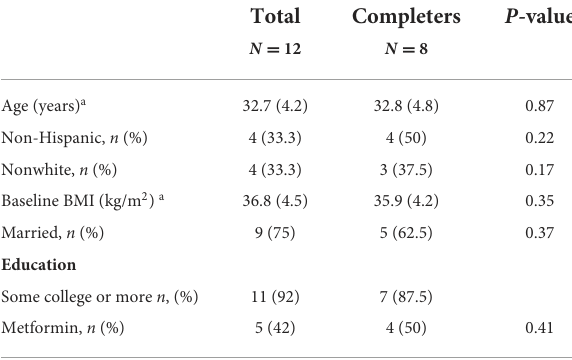
TABLE 1 Baseline demographics for total sample and completers